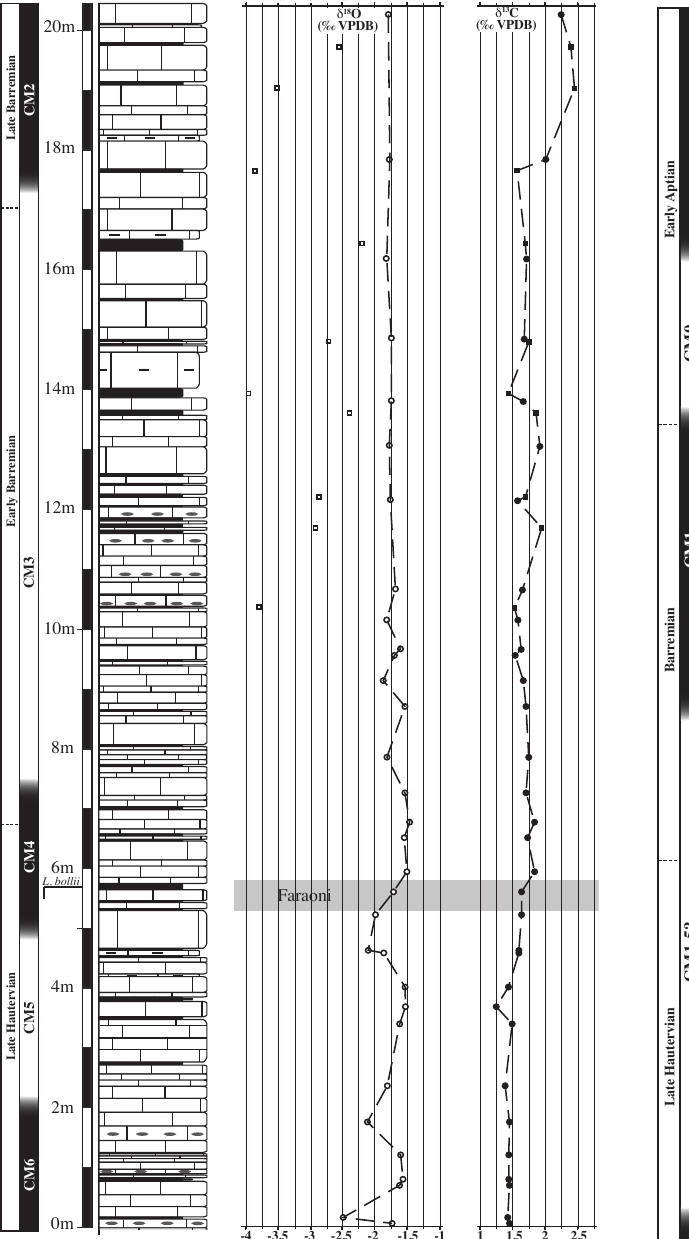
Föllmi et al., Fig. 6 Fig. 6. The Capriolo section: stable carbon and oxygen isotope val- ues for carbonate